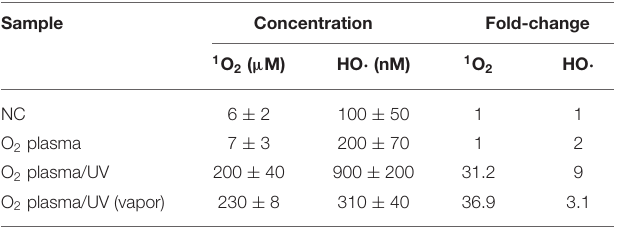
TABLE 2 | Reactive oxygen species (ROS) analysis using electron spin resonance (ESR) in various radical vapor reactive modes. Sample Concentration